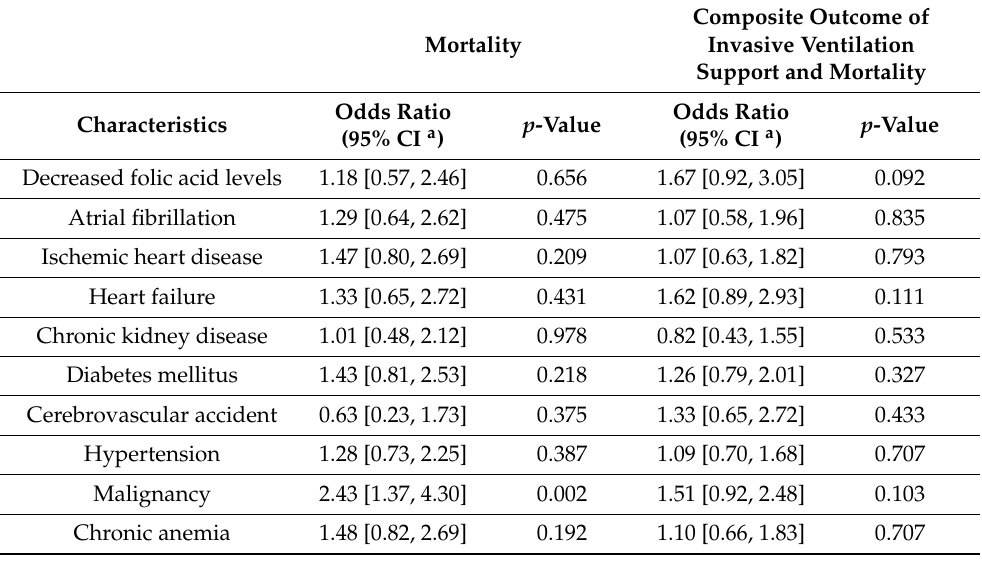
Table 6. Adjusted analysis for the association between decreased folate levels and mortality and a composite of invasive ventilation support and mortality in patients hospitalized with COVID-19. Composite Outcome of Mortality Invasive Ventilation Support and